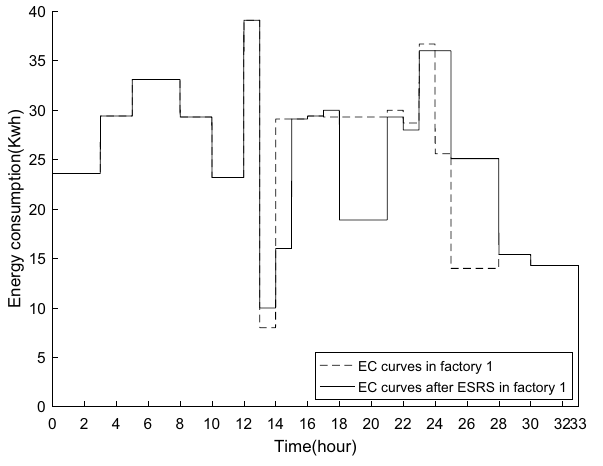
Figure 10. The EC curve in factory1.